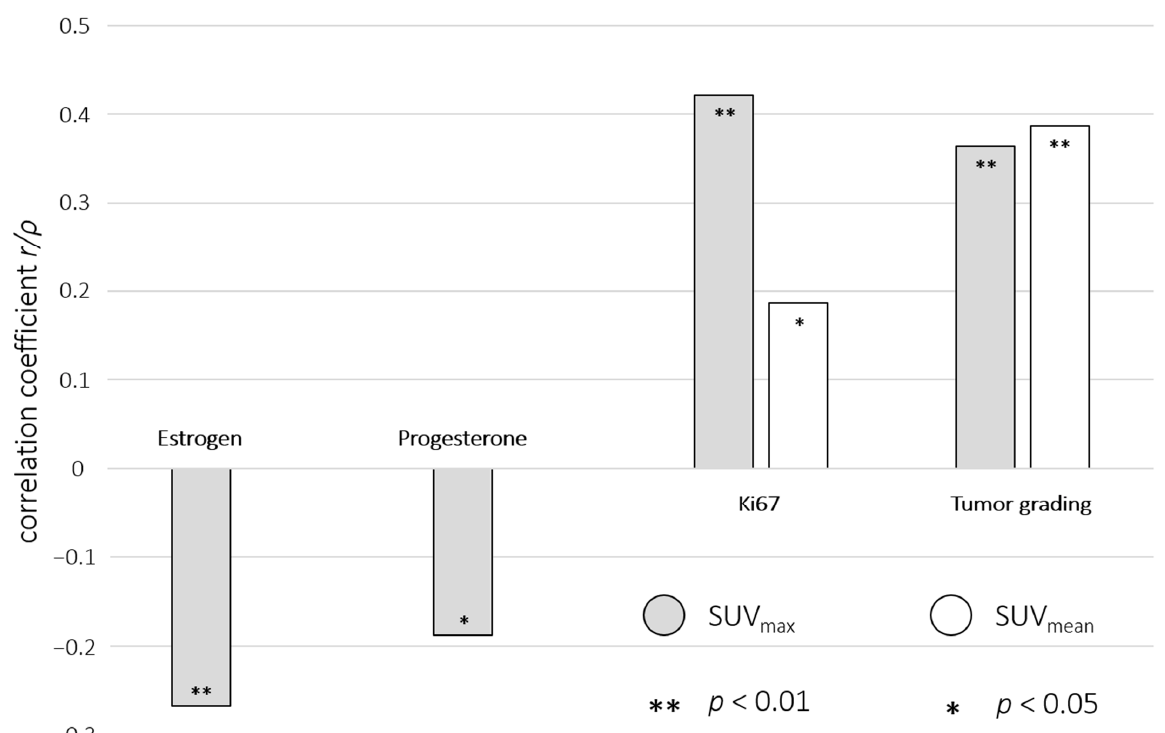
Figure 4. Visualized significant correlations between immunohistochemical markers, tumor grading, and SUV max (grey)/SUV mean (white) from [ 18 F]FDG-PET/MRI in combination with their correlation coefficients ( r/ ρ ) and p values (** p < 0.01; * p < 0.05). Table 3. Comparison of SUV max /SUV mean /ADC mean values derived from defined BM regions at [ 18 F]FDG-PET/MRI between DTC-positive and DTC-negative patients using Mann–Whitney-U test. Descriptive group statistics (median ( Mdn ), interquartile range ( IQR )) and results of Mann–Whitney-U test are